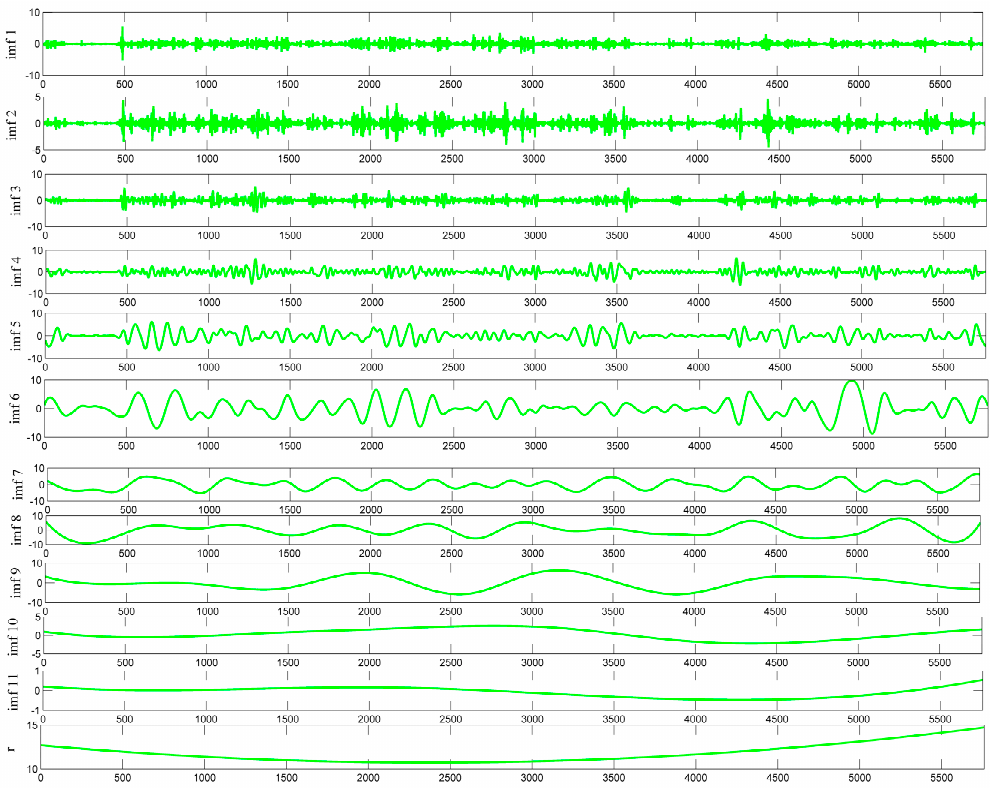
Figure 5. Decomposition by EEMD of wind power series.